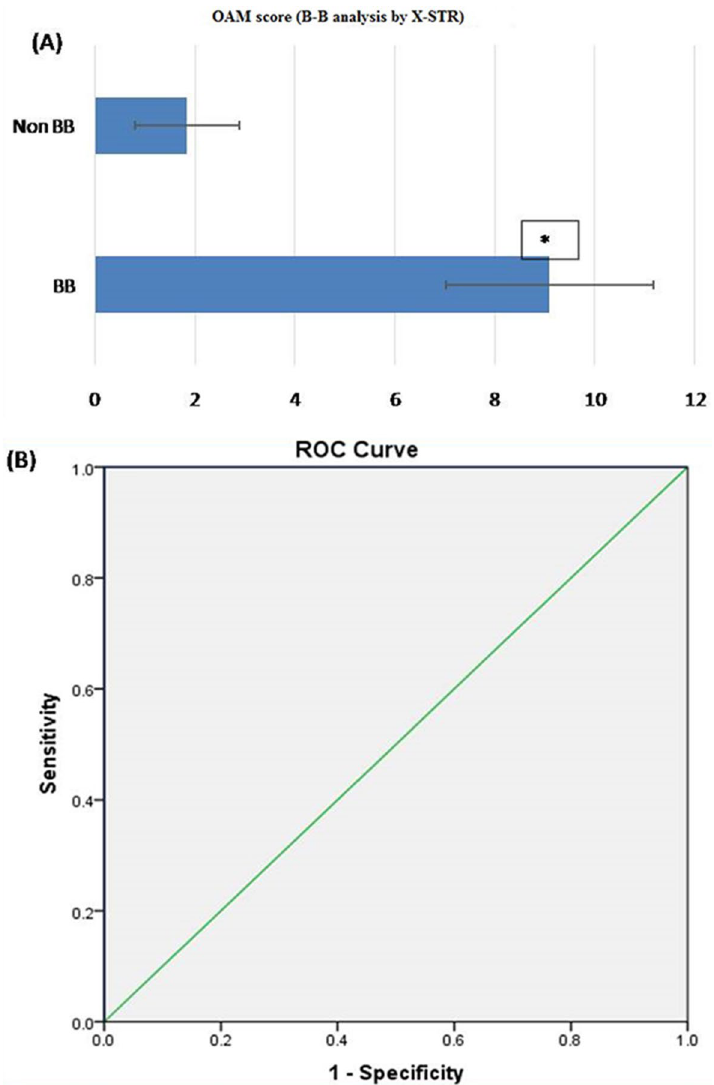
Figure 4. ( A ) OAM score for B-B analysis by X-STR. Based on OAM score, statistically significant difference between B-B and non-B-B group was seen with X-STR. The Average OAM score for the B-B group is 9.1 ± 2.075 (SD), whereas for the non-B-B group average OAM score is 1.85 ± 0.040 (SD). Figure 4 (A & B) obtained from SPSS software version 22.0 (Available for download at: https:// www. ibm. com/ suppo rt/ pages/ downl oading- ibm- spss- stati stics- 22). *Statistically significant difference ( p < 0.05). ( B ) ROC curve (AUC 100%), showing the performance of OAM score as a screening test for B-B pairs by